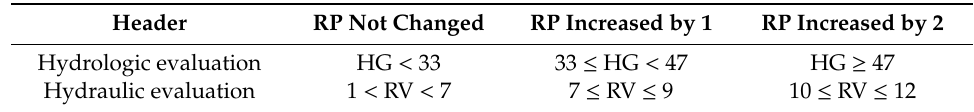
Figure 2. Schematic of developed safety-inspection methodology. Table 10. Determination of risk point (RP) value using hydrological grade (HG) and ranking values (RV).